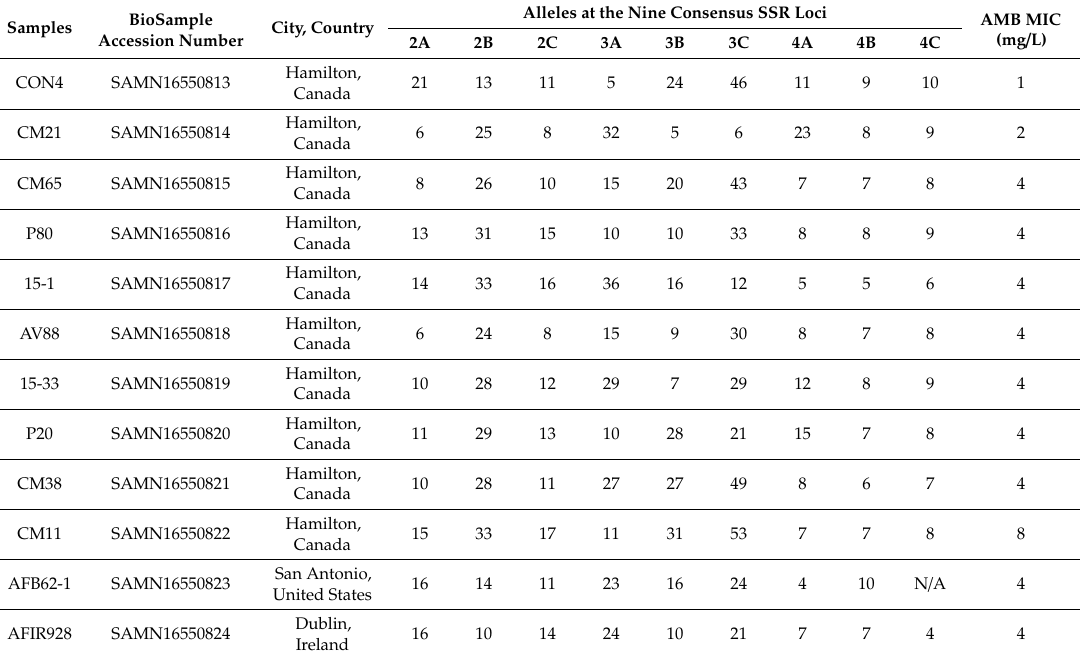
Table 1. Microsatellite genotypes of 12 Aspergillus fumigatus strains and their in vitro susceptibility to amphotericin